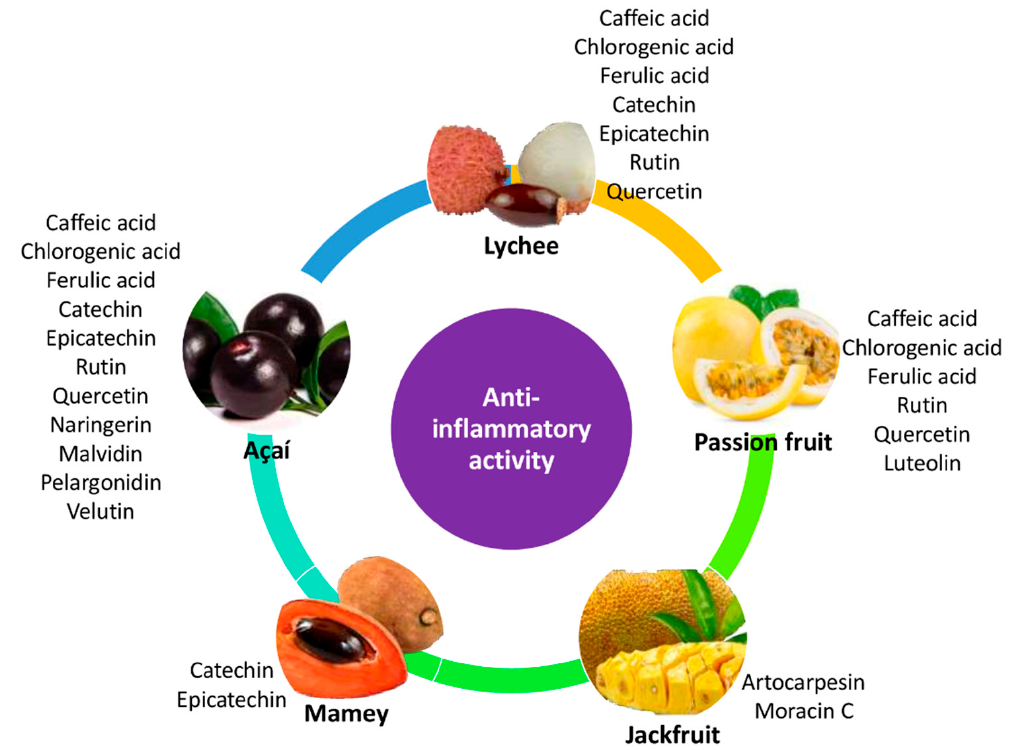
Figure 3. Main bioactive compounds present in lesser-consumed tropical fruits (lychee, mamey, passion fruit, aça í and jackfruit) known to exert significant anti-inflammatory